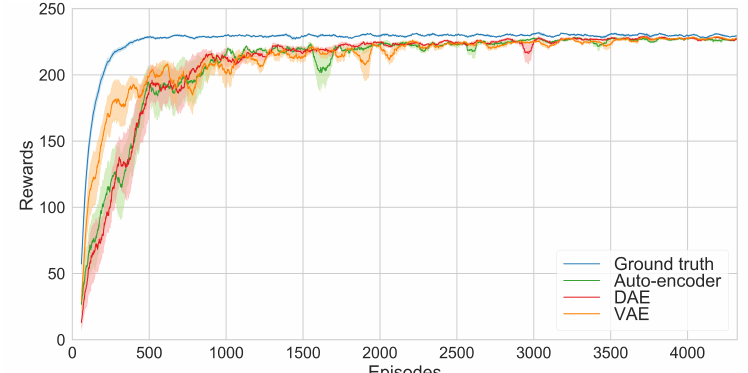
autoencoder methods using PPO